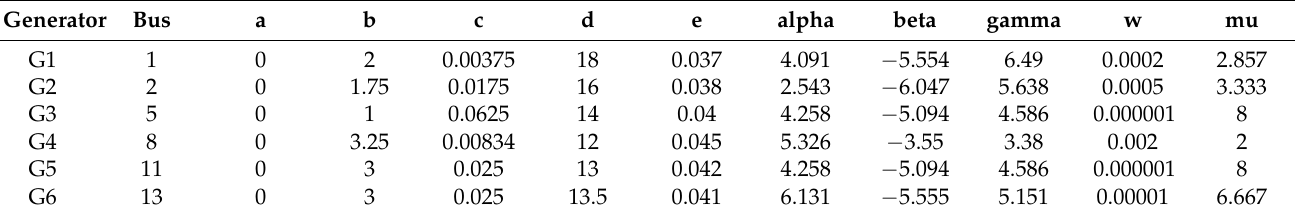
Table 1. Cost and emission coefficients of generators for the IEEE 30-bus